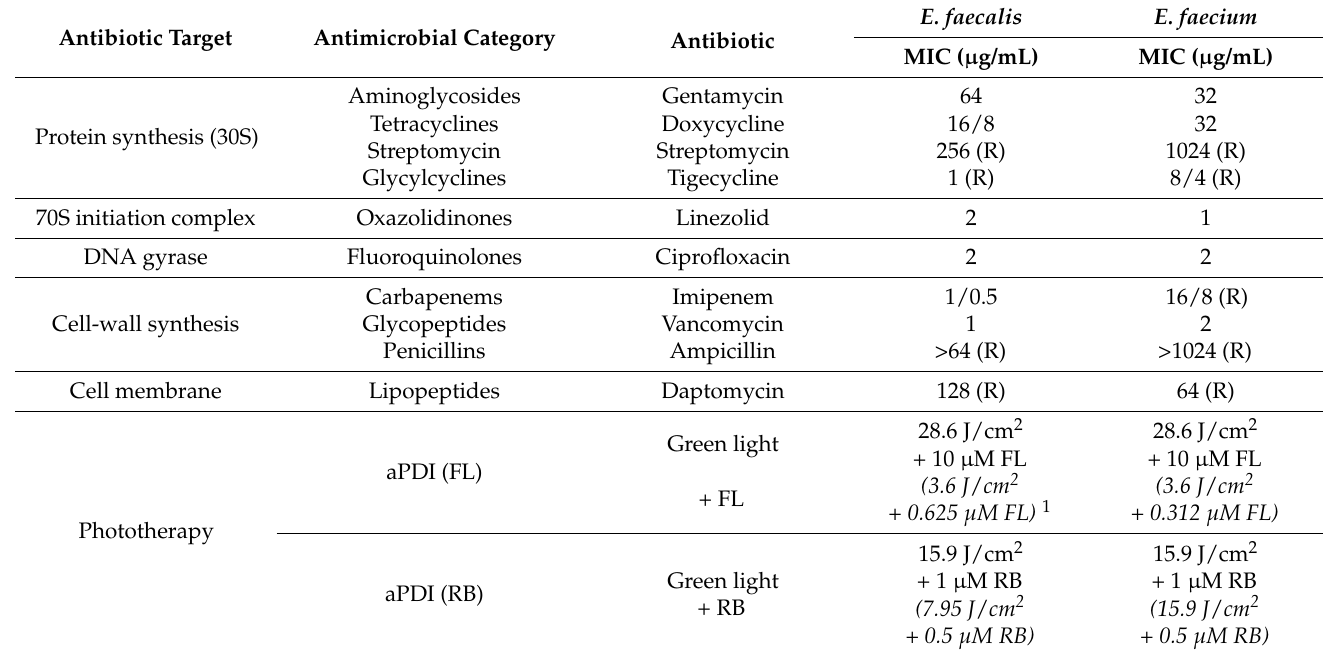
Table 1. MIC for antimicrobials and